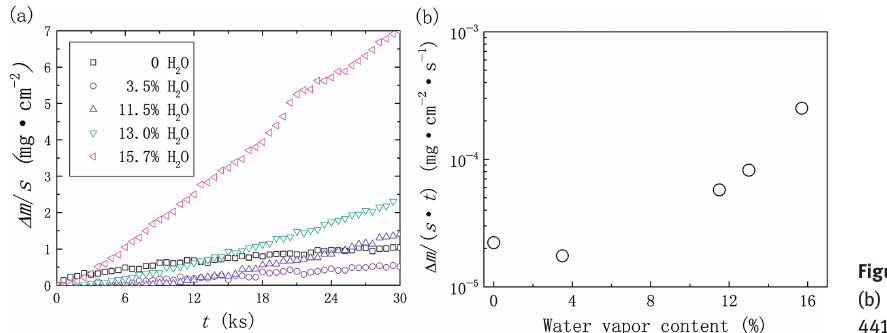
Figure 2: (a) Mass-change profiles and (b) absolute value of k s of stainless steel 441 in wet air